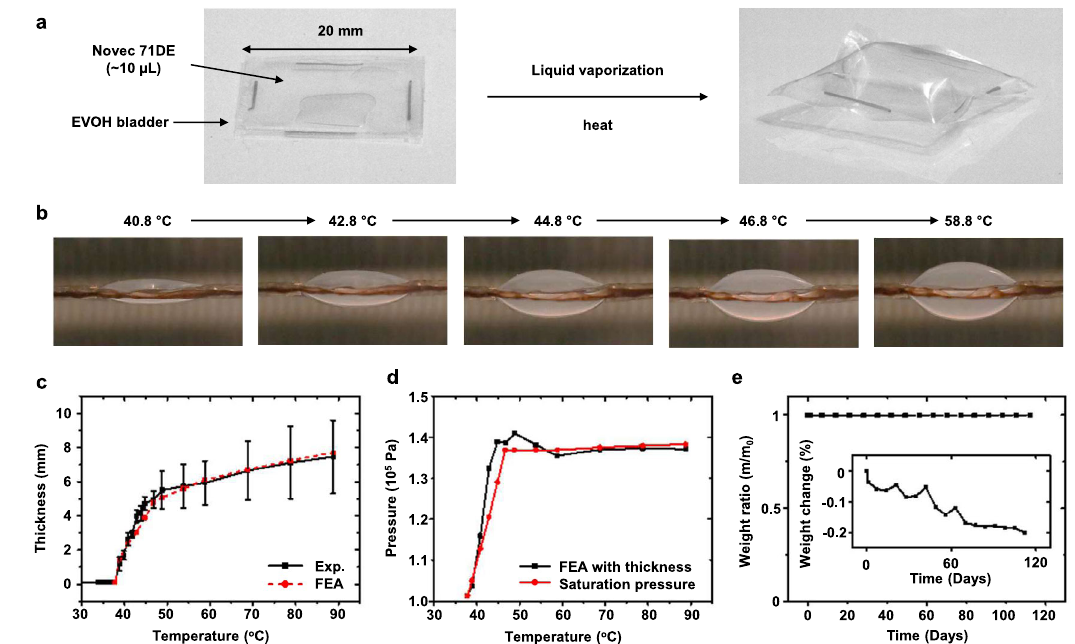
Fig. 2 | Thermomechanicalexpansion of a liquid – vaporbladder.a Photographs ofliquid – vaporbladdersbeforeandafterheating.Theheatvaporizestheliquidand expands the bladder. The lateral dimensions of the bladder are 20mm by 20mm, and the volume of liquid (Novec 71DE) enclosed is ~10 µ L. b Photographs of liquid – vapor bladders expanded at different temperatures. c Maximum thickness as a function of temperature for expanded liquid – vapor bladders loaded with ~10 μ L volumes of liquid. Solid and dashed lines represent results based on